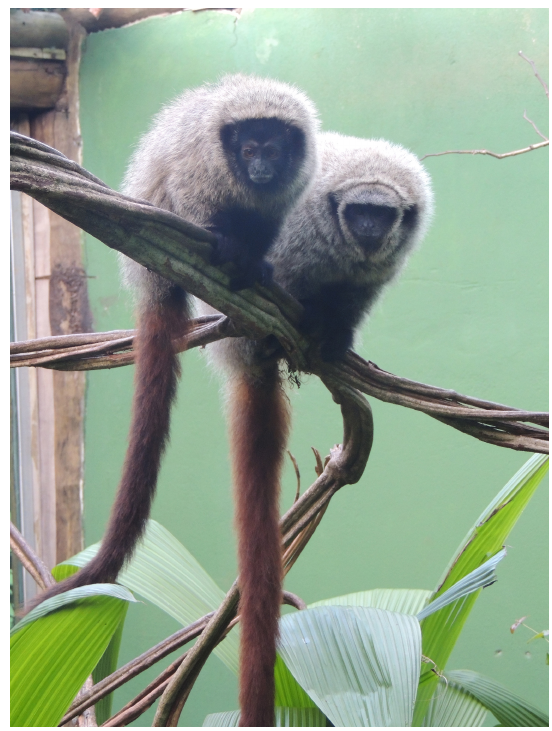
Figure 1. Two captive titi monkeys, Callicebus coimbrai (left) and Callicebus barbarabrownae (right), monitored during the study at the Getúlio Vargas Zoobotanical Park. Photo: João Pedro Souza-